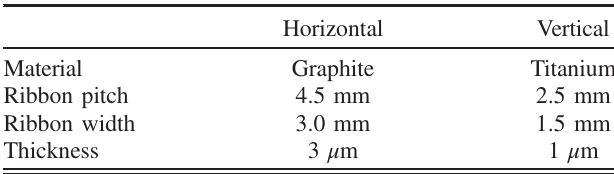
TABLE I. Inj-MRPM specifications. The thickness of the electrodes is the same as the